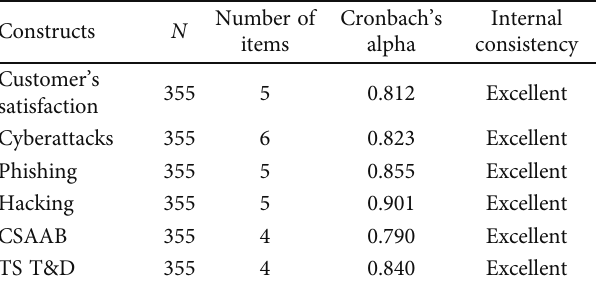
Table 3: Reliability of measurements.